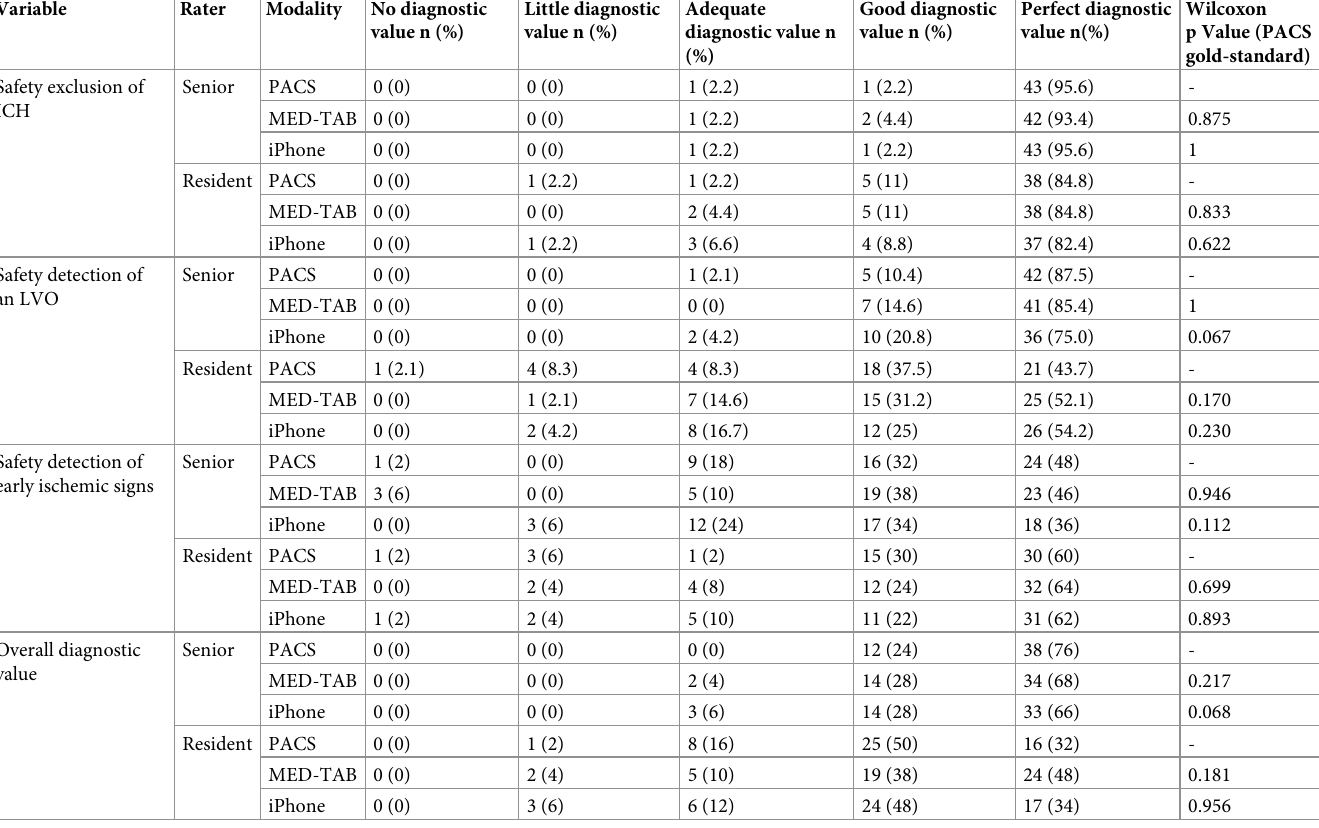
Table 6. Qualitative rating of diagnostic value of the three devices.